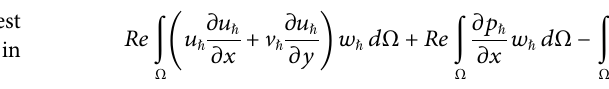
Frontiers in Physics |